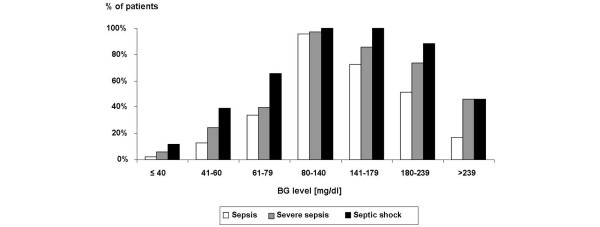
Rate of patients with the indicated blood glucose (BG) levels during sepsis across the different sepsis groups. The different columns correspond to the proportion of patients who had at least one BG value within the indicated BG ranges during sepsis. Note that a patient can be included in more than one column.